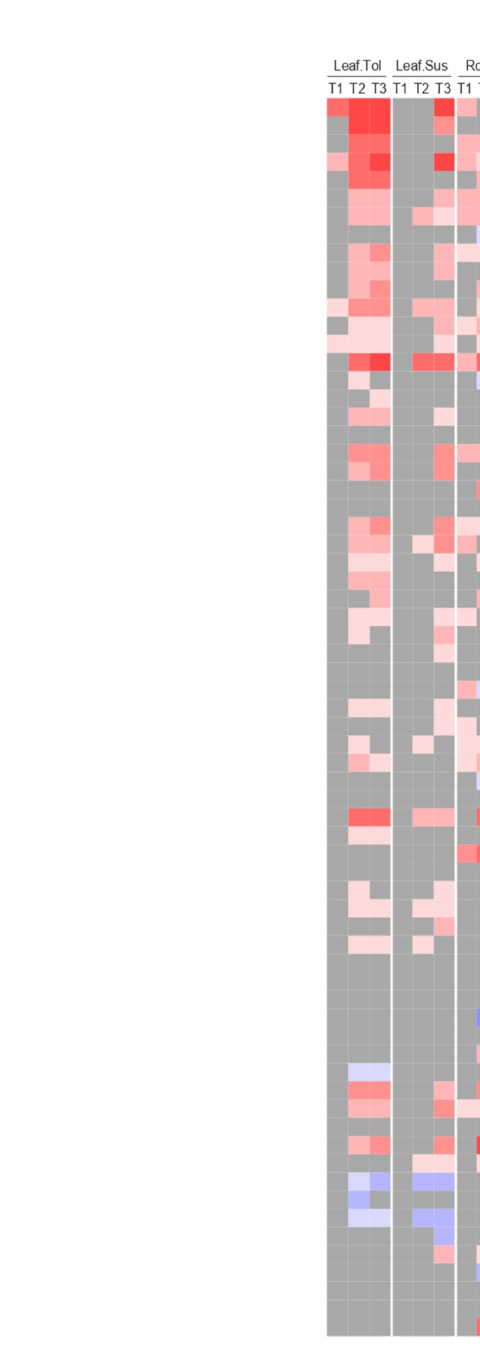
FIGURE 6 Heatmap of the log2 fold change of WRKY genes. Shown is the log2FC expression of WRKY genes differentially expressed in either tissue in two potato varieties at any time point compared to the non-stressed